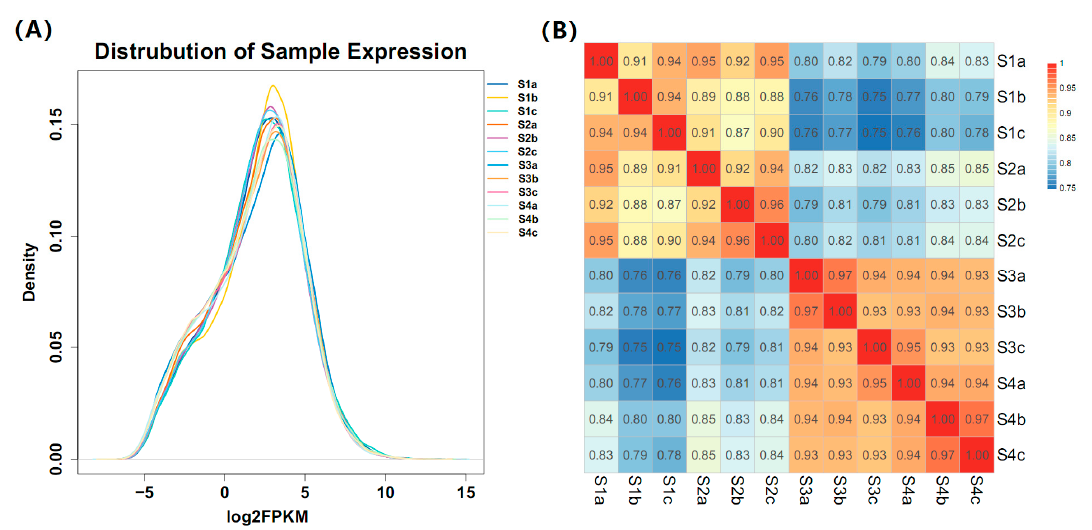
Figure 2. Overview of the gene expression profiles at four stem swelling stages in stem mustard. ( A ) The density of gene expression in each sample. The expression level of each gene was normalized as FPKM (fragments per kilobase of exon per million fragments mapped). FPKM values were log2-based. ( B ) Pearson’s correlation coefficients (PCCs) of gene expression among different stages. S1, S2, S3 and S4 indicate four stages, and a, b and c represent three biological replicates.